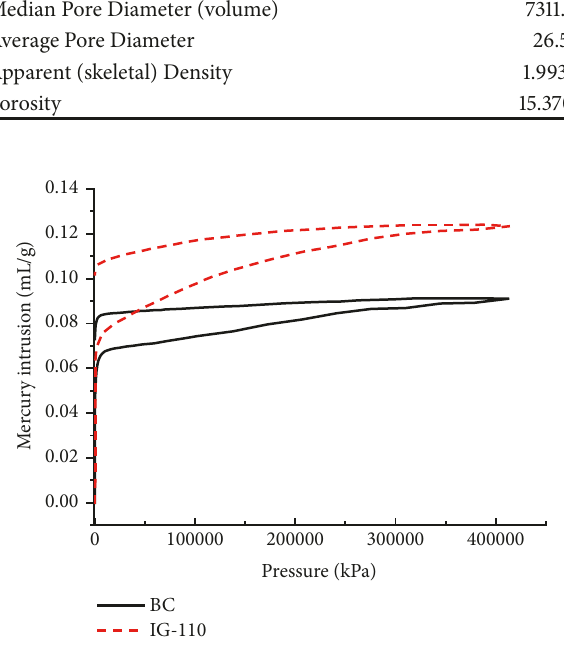
Figure 8: The mercury intrusion and extrusion curves of BC and IG-110. The mercury intrusion volume of IG-110 is larger than that of BC under same